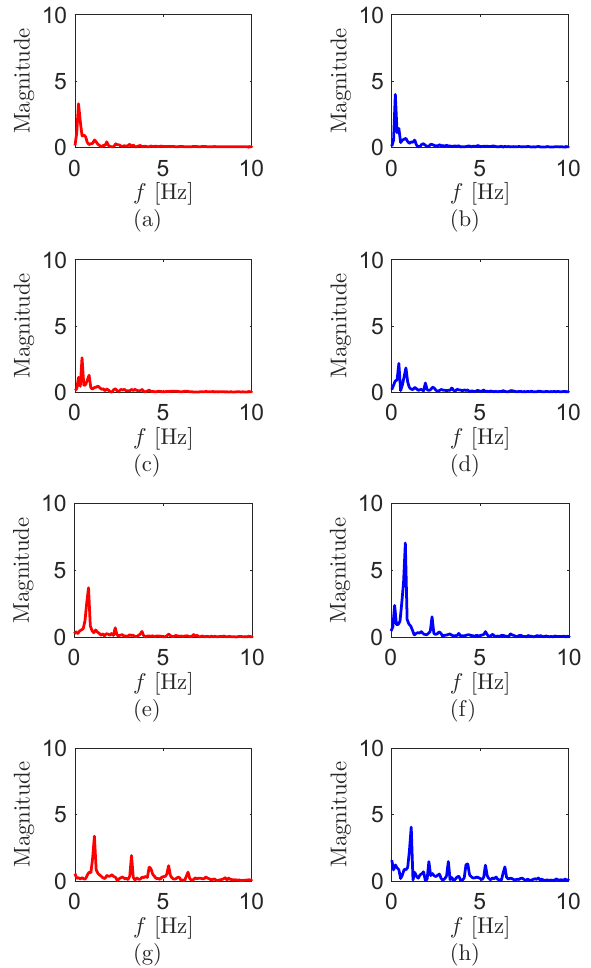
Figure 5. FFT magnitude spectra during walking of ( a ) left and ( b ) right hip at 0.5km/h, ( c ) left and ( d ) right hip at 1km/h, ( e ) left and ( f ) right hip at 3km/h, and ( g ) left and ( h ) right hip at 6km/h.